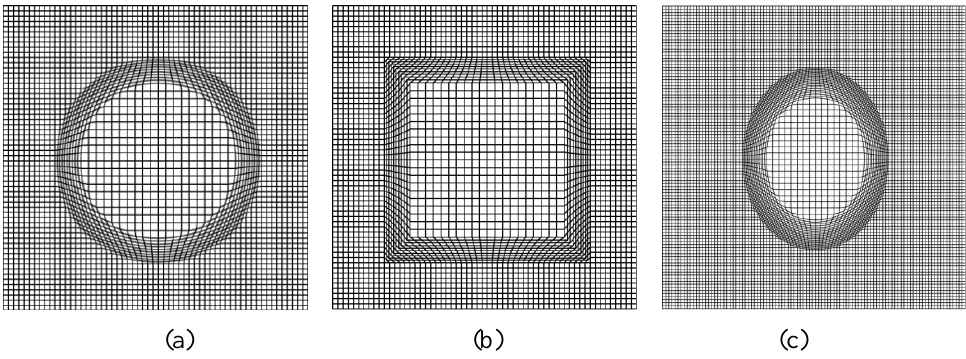
Figure 3. Shapes of the focus area: ( a ) circle; ( b ) rectangle; ( c ) ellipse.